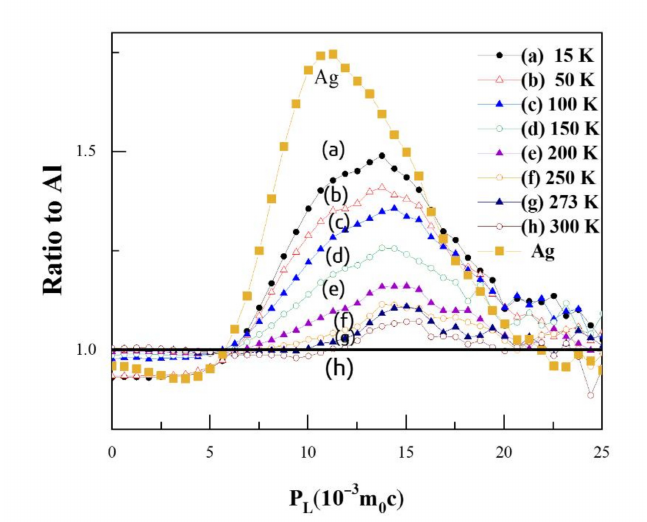
Figure 5. Coincidence doppler broadening (CDB) ratio curves for Al-0.2 wt.%Ag at different temper- atures. The statistical errors are omitted for clarity of